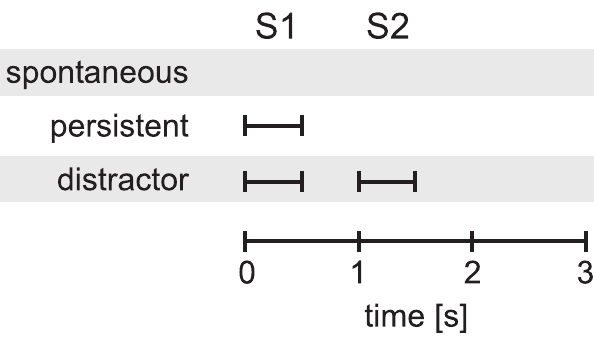
Figure 9. The Simulation Protocols Stimuli to either S1 or S2 are applied at different times depending on the type of simulations. The spontaneous simulations include no input.